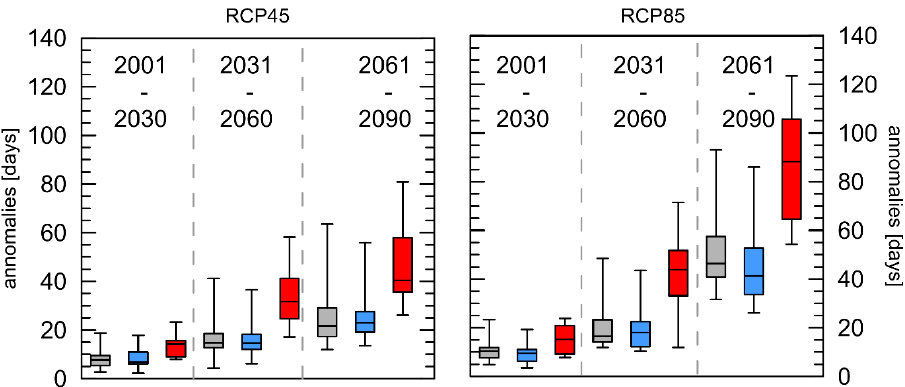
Figure 4. Boxplots of mean anomalies of the number of days’ contribution to heat waves each year (HW-F) with reference to the 30-year period 1971–2000 for the three cities London (grey), Luxembourg (blue), and Rome (red) and two different RCPs. Whiskers = 5/95 percentile.